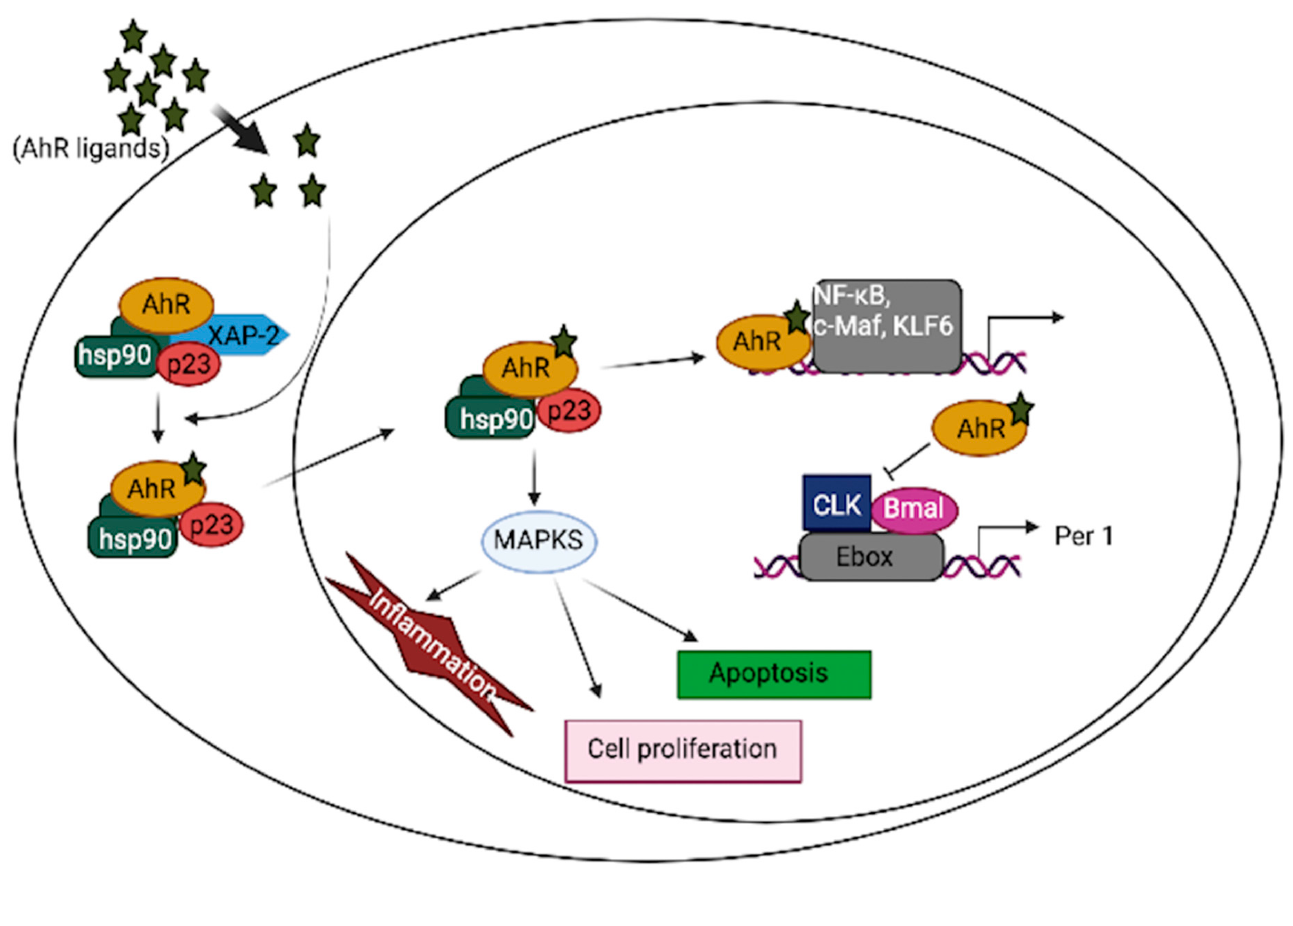
Figure 1. ( a ): AhR canonical pathway activation. ( b ): AhR non-canonical pathway activation. Apart from xenobiotics, such as TCDD, and other polycyclic aromatic hydrocarbons (PAHs) that cross the blood-brain barrier (BBB) to mediate some of AhR’s effects in the brain, several endogenous tryptophan metabolites, such as kynurenine, serotonin, and 6-formylindolo [3,2-b] carbazole (FICZ), are implicated in AhR-related brain function and pathology [47,48]. Recently, attention has been drawn to the kynurenic pathway and microbial metabolites in the gut-brain axis, as well as central nervous system (CNS) devel- opment and diseases [48,49]. In the brain, L-tryptophan is primarily metabolized through kynurenic pathways, producing several ligands that bind to AhR [50]. AhR activation in glial cells by the microbial metabolism of dietary tryptophan interferes with the NF- κ B inflammatory transcription program, thereby reducing neuroinflammation, which raises the possibility that this pathway could be targeted in neurodegenerative and autoimmune diseases in the CNS [51,52]. In addition to several gut microbiota metabolites, FICZ, an endogenous ligand of AhR, promotes neurogenesis in adult neurons, which is needed for hippocampal memory maintenance in mice. Several brain-related pathological conditions may also involve the non-canonical activation of AhR. For instance, in Alzheimer’s disease pathology, tryptophan derivatives (kynurenic acid and 5-hydroxyindole-acetic acid) can increase neprilysin expression, which is necessary for regulating amyloid beta clearance by proteolysis [53]. In neuronal cancers, such as glioma, AhR activation promotes a malig- nant phenotype by engaging transforming growth factor- β (TGF- β )/Smad [54,55]. Taken together, the available evidence suggests that AhR signaling plays a pivotal role in brain function and that its dysregulation may contribute to diseases of the